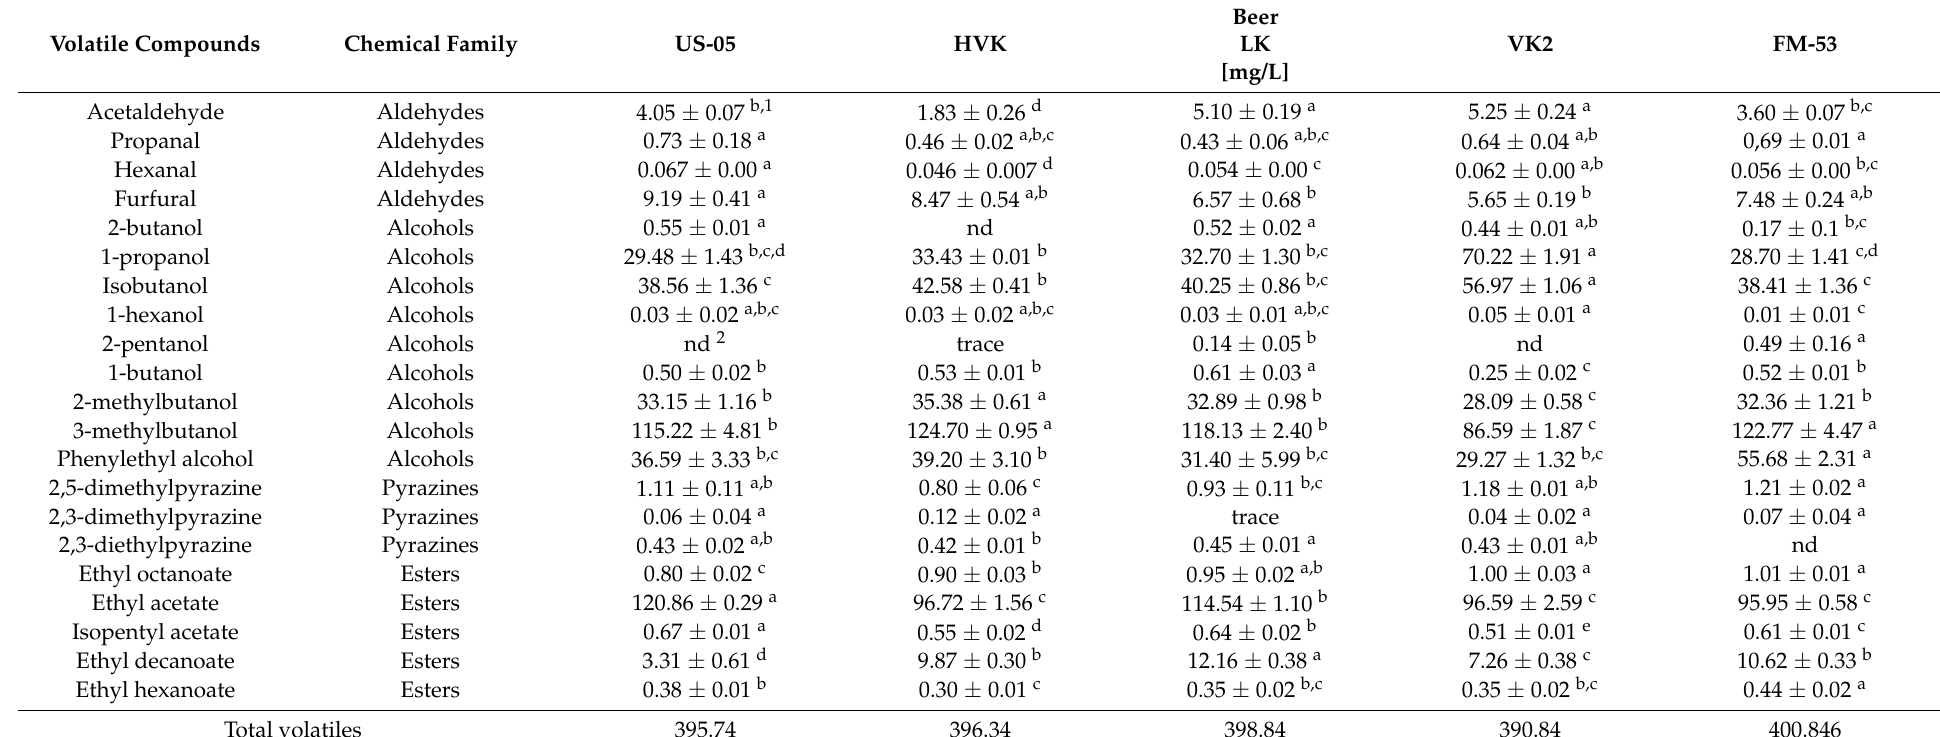
Table 4. Analysis of volatile compounds of the